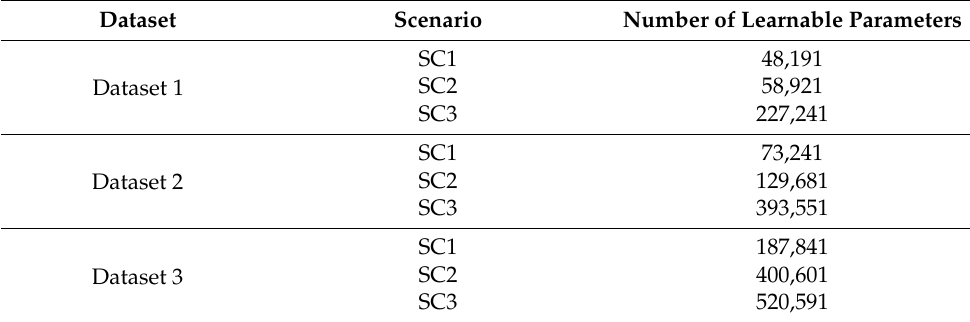
Table 6. The number of learnable parameters for 1DCNN in different scenarios.